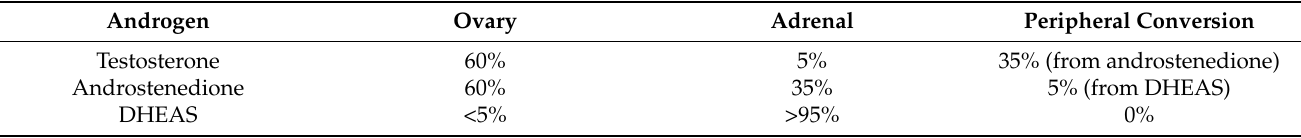
Table 2. Sources of serum androgens in PCOS